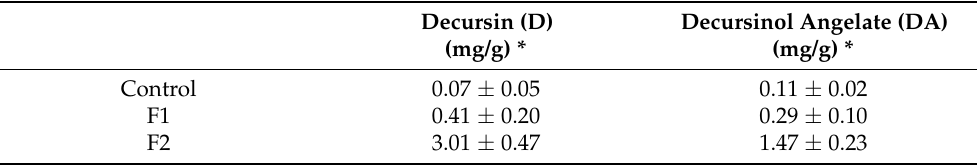
Table 3. D and DA contents of control and HME formulation of AGN.